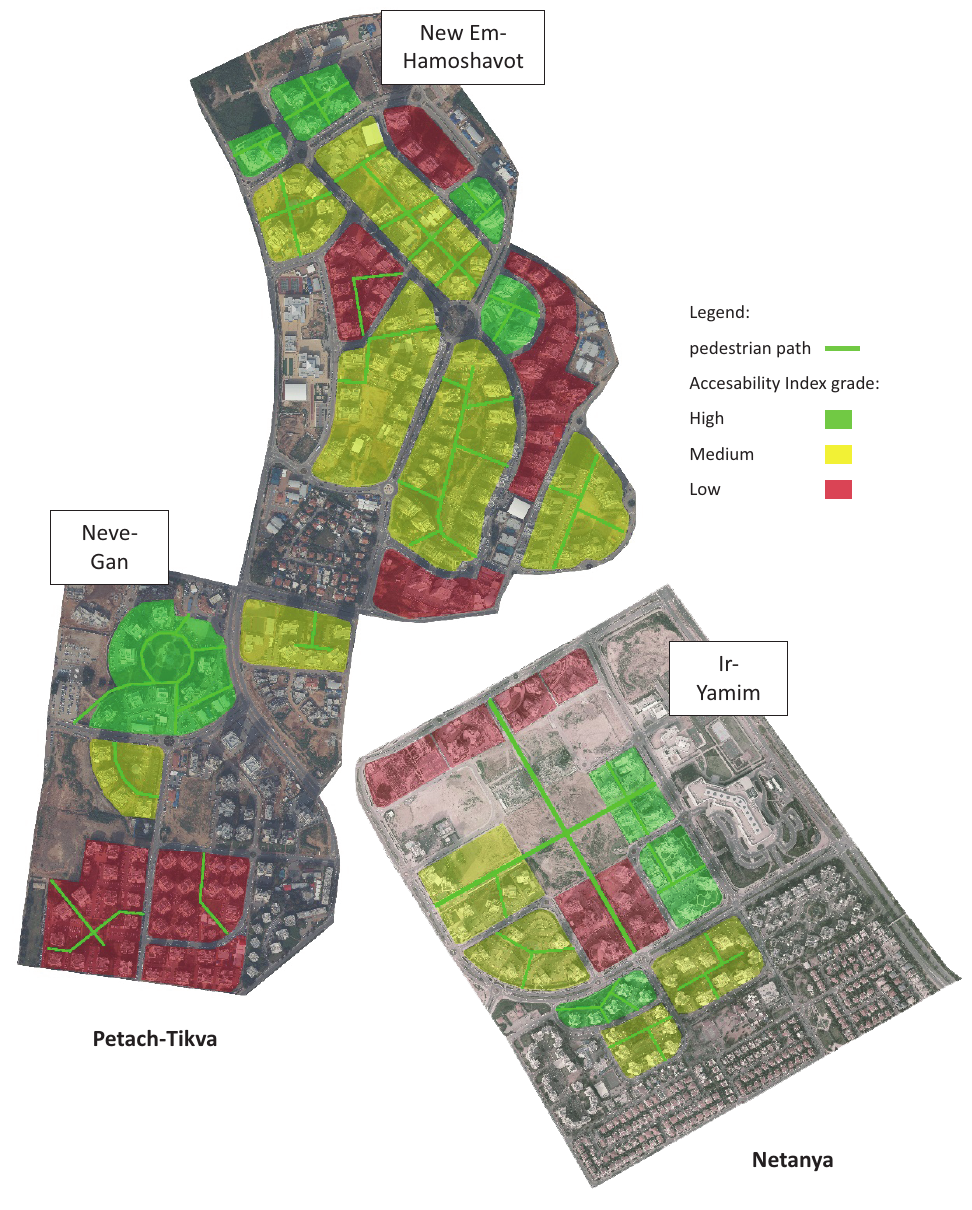
Figure 6. Accessibility scheme of HRHC neighborhoods.